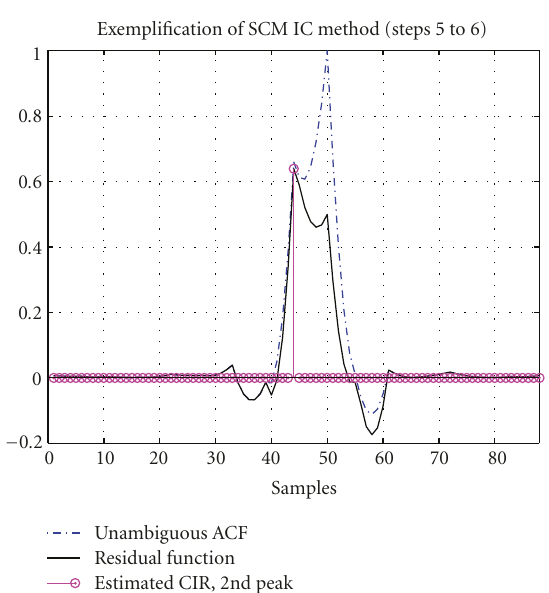
Figure 10: Exemplification of SCM IC method, 2-paths fading channel with true channel delay at 44 and 50 samples, average path powers [ − 2,0]dB, SinBOC(1,1)-modulated